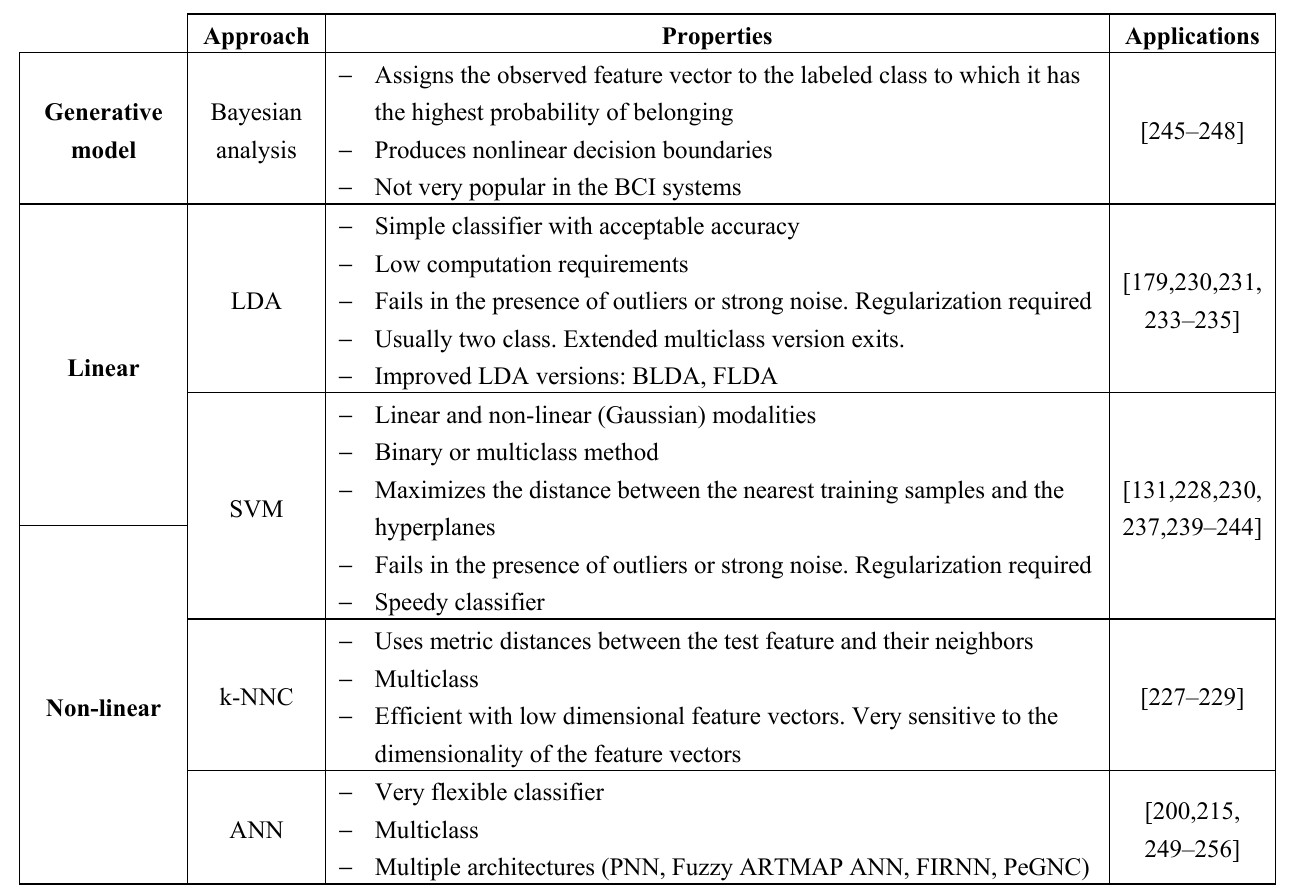
Table 8. Summary of classification